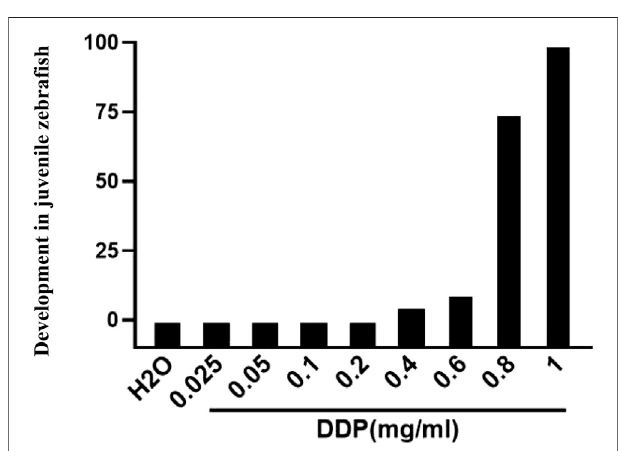
FIGURE 5 | Impacts of different cisplatin concentrations on the overall development in juvenile zebra fi sh (3 – 6 dpf).